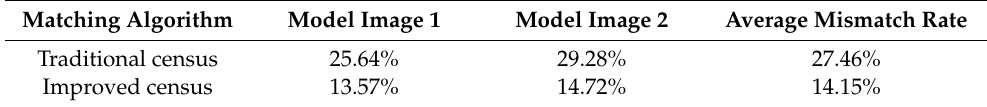
Table 1. The corresponding mismatching rate of the census algorithm before and after improvement.